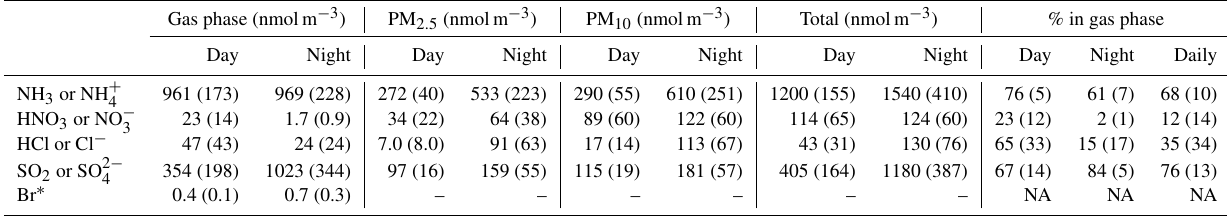
Table 4. Mean ( ± standard deviation) concentrations of reactive gases, particulate phase inorganic ions, and percent of these species in gas phase. Total concentrations correspond to the sum of gas phase and PM 10